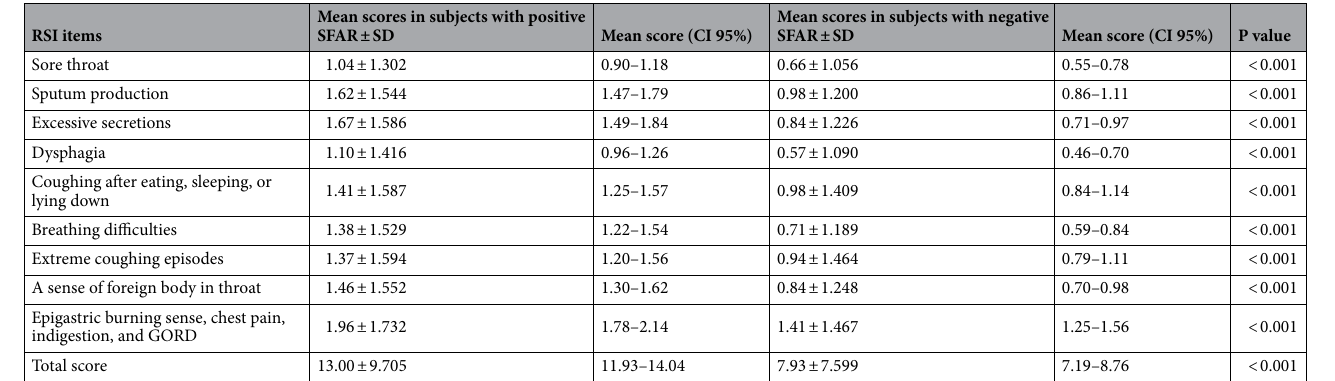
Table 4. Comparing each RSI item with subjects with positive and negative SFAR. Independent t-test was used to determine the significance of the comparisons in this table. CI: confidence interval; SFAR: score for allergic rhinitis; RSI: reflux symptom index; SD: standard deviation; GORD: gastro-oesophageal reflux